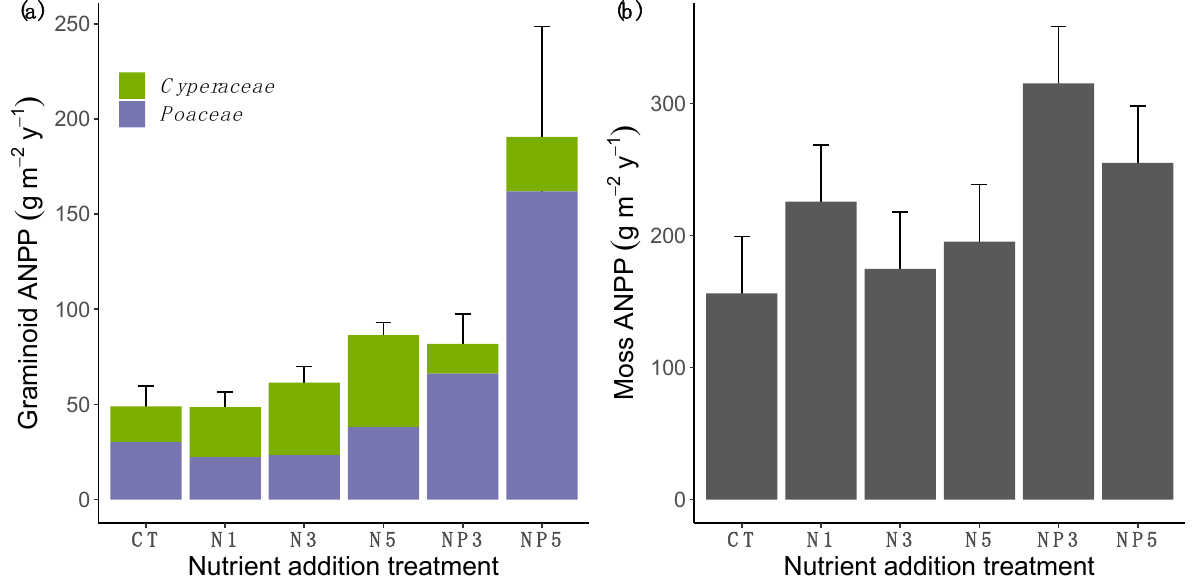
Figure 2. Aboveground net primary productivity (ANPP) of ( a ) graminoids separated by graminoid family and ( b ) mosses according to fertilization treatments after 17 years of experimentation in the tundra wetlands of Bylot Island, Nunavut. Least square means + SE are presented. See Methods for definition of treatments.